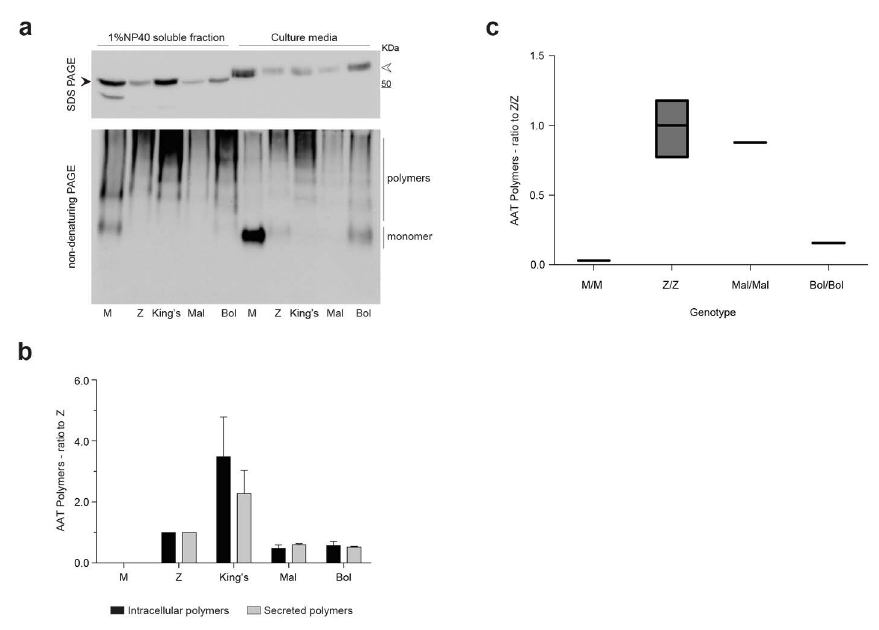
Figure 3. Intra- and extracellular polymers of the Bologna AAT variant. ( a ) HEK293T cells were transfected to express wild-type M AAT or the indicated AAT variants. Forty-eight hours after transfection, the cell culture media were collected, and the cells lysed in 1% v / v NP-40 buffer. All samples were separated by 10% w / v SDS-PAGE (upper panel) or 8% w / v non-denaturing PAGE (lower panel), and AAT was detected by immunoblotting with a polyclonal antibody (Dako). ( b ) The same samples analyzed in panel A were tested by sandwich ELISA using the 2C1 mAb to capture AAT polymers only. The graph shows mean ± SEM ( n = 2) of the concentration of intracellular (black bars) and secreted (grey bars) polymers, calculated by using a standard curve and normalized to polymer levels in the Z AAT samples. ( c ) Quantification of AAT polymers in the plasma of a PI*Bologna/Bologna AAT homozygous patient. Polymers were quantified by ELISA using the 2C1 mAb for capture, and including plasma samples from one PI*Mmalton/Mmalton, three PI*Z/Z and two PI*MM subjects as